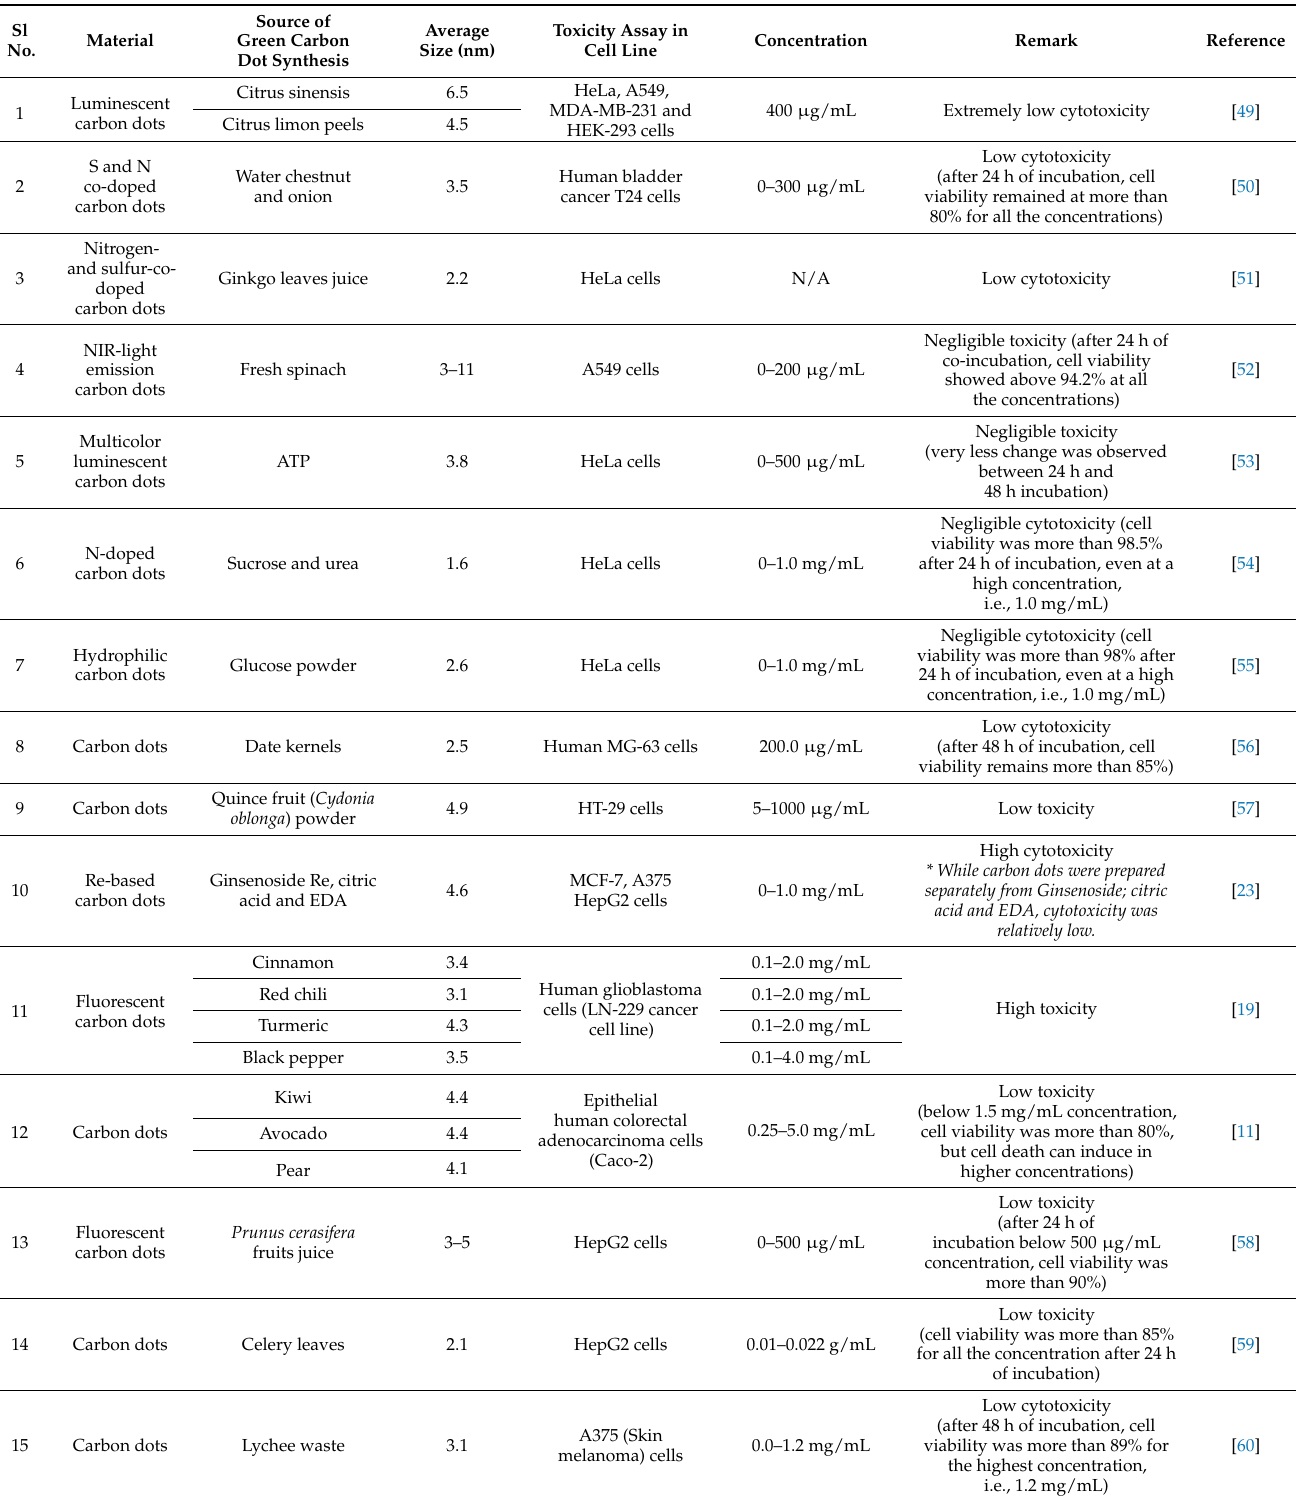
Table 10. Toxicity assay of GCDs for cancerous